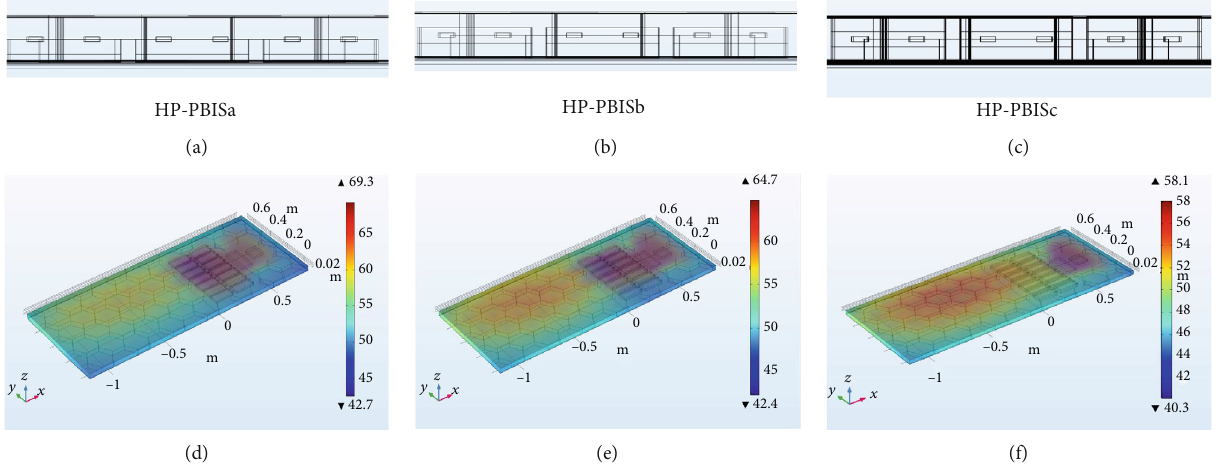
Figure 13: Structural model diagrams: (a) single layer — 5 × 165 × 75mm 3 , (b) single layer — 10 × 165 × 75mm 3 , and (c) double layers — 10 × 165 × 75mm 3 ; and temperature contours of (d) HP – PBISa, (e) HP – PBISa, and (f) HP – PBISa under air convection mode at